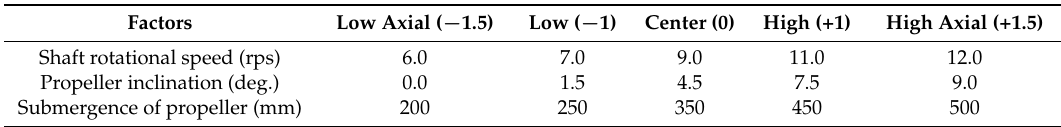
Table 1. Factors used at different levels of the